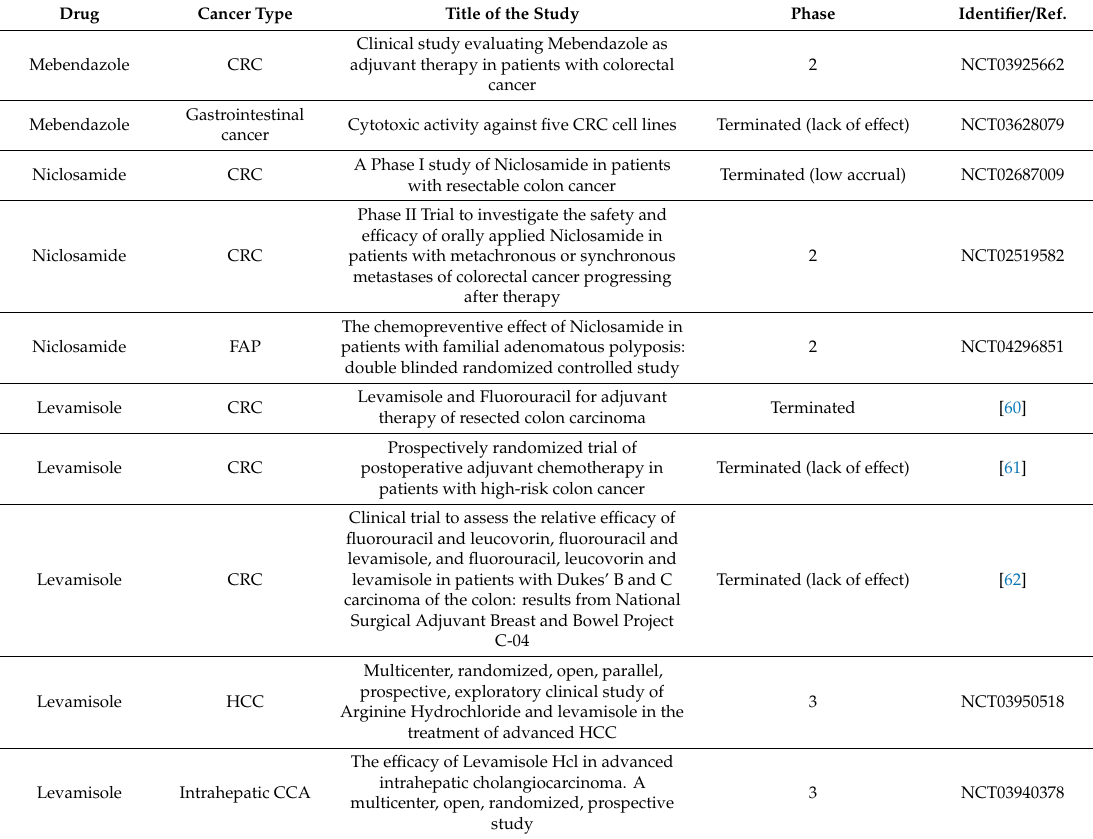
Table 2. Anthelmintic drugs employed in clinical trials to treat cancers of the digestive system.